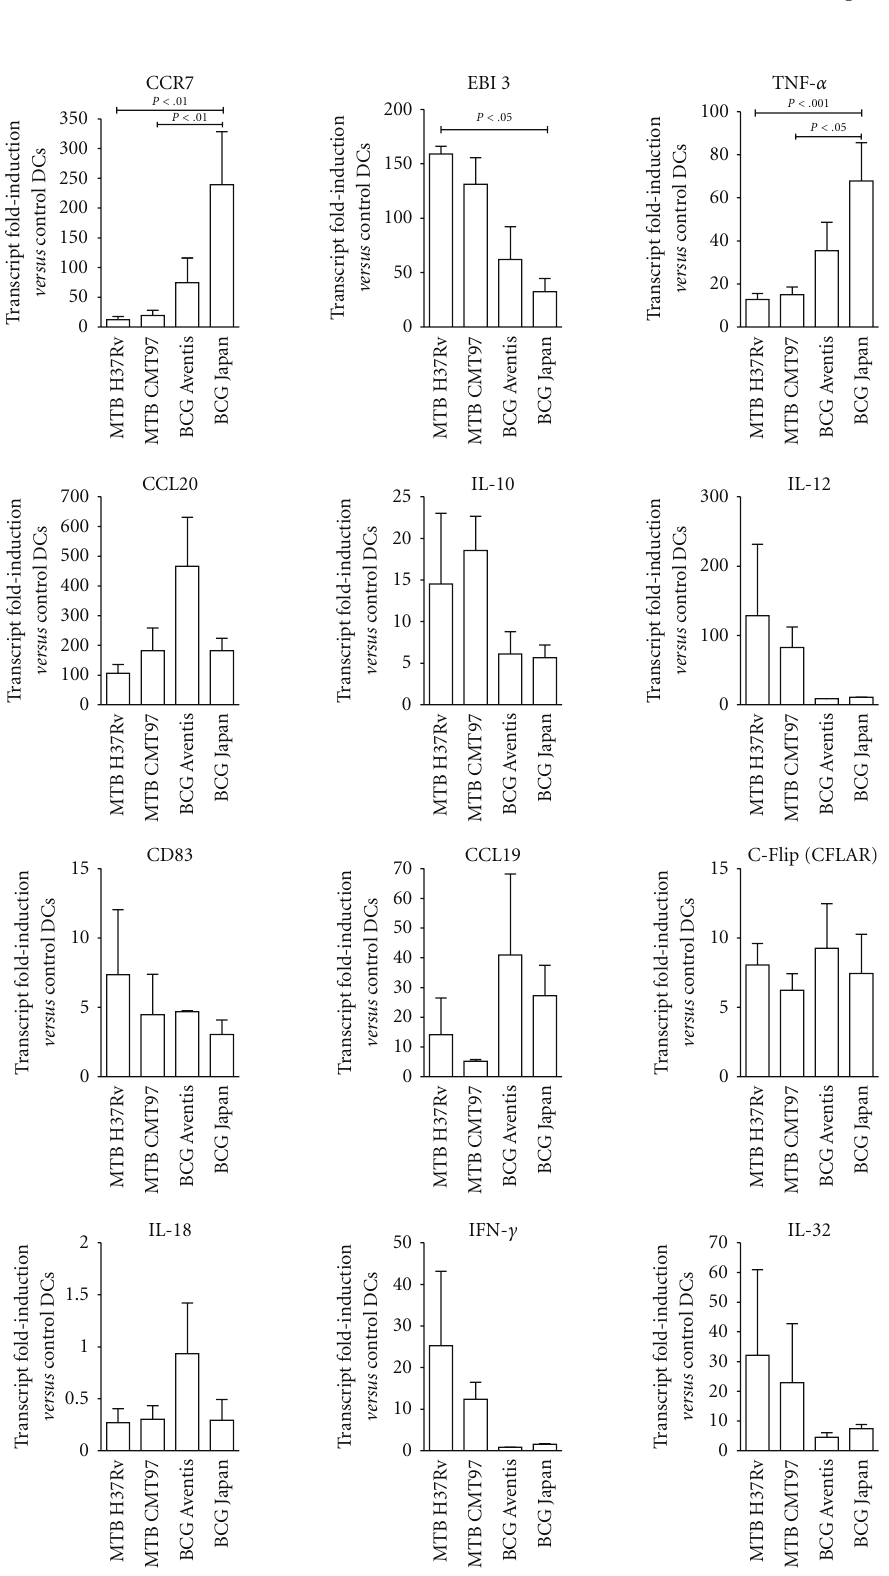
Figure 4: Analysis of RNA modulation by q-rt RT-PCR . Total RNA from DCs exposed for 3h to MTB H37Rv, MTB CMT97, BCG Aventis and BCG Japan was assayed for gene expression by q-rt RT-PCR, 1-day culture after the infections. Gene expression was normalized to L34 and fold change was calculated with respect to uninfected DCs. Data are from 3 individual experiments and are expressed as mean ± SEM. The presence of significant di ff erences in gene expression between DCs was calculated by a one-way